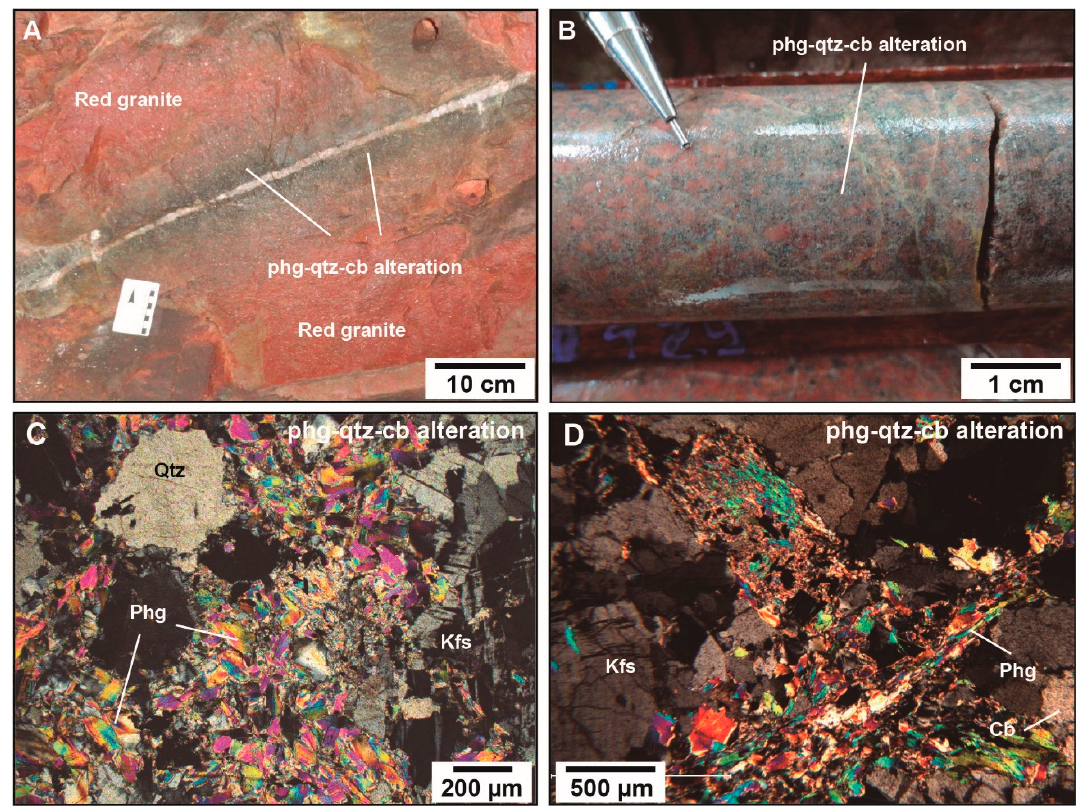
Figure 8. Phengite–quartz–carbonate (PQC) alteration associated to gold mineralisation in the Passa Três granite: ( A ) PQC alteration halo along a barren quartz vein (underground mine level 3); ( B ) PQC alteration in borehole resulting in a grey colour of the Passa Três granite; ( C ) Photomicrograph showing the development of small phengite crystals as an alteration of K-feldspar and plagioclase in a medium-grained isotropic texture; ( D ) Two fractures underlined by the concentration of phengite crystals as part of the PQC alteration. Images ( C , D ): optical microscope—polarised light.